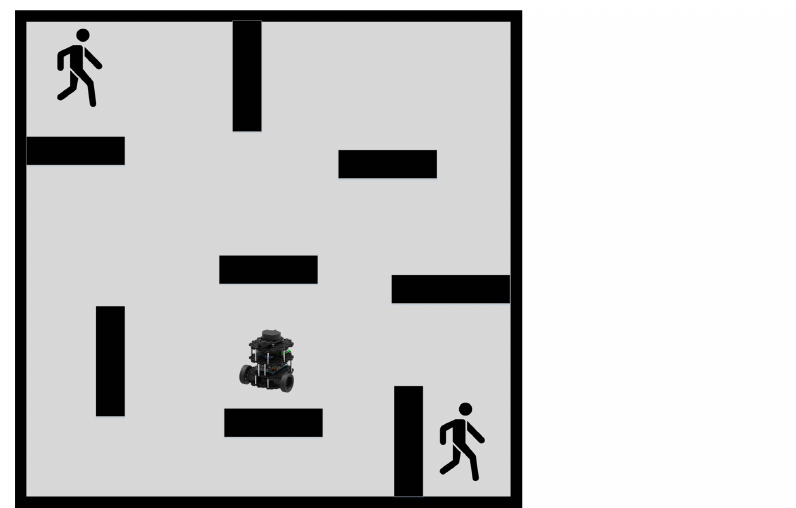
Figure 9. Dynamic Environment.